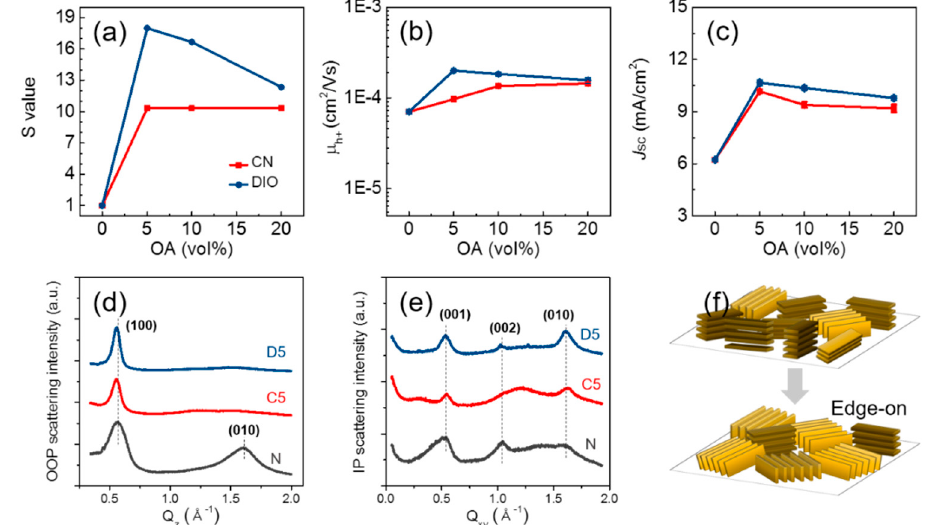
Figure 6. Various PCPDTBT films characterized by ( a ) normalized surface area increment (S value); ( b ) hole mobility ( μ h+ ); and ( c ) J SC versus OA volume; the grazing-incidence wide-angle X-ray scattering (GIWAXS) line-cuts in the ( d ) out-of-plane (OOP) direction and ( e ) in-plane (IP) direction; ( f ) proposed PCPDTBT film orientation change after OA addition.